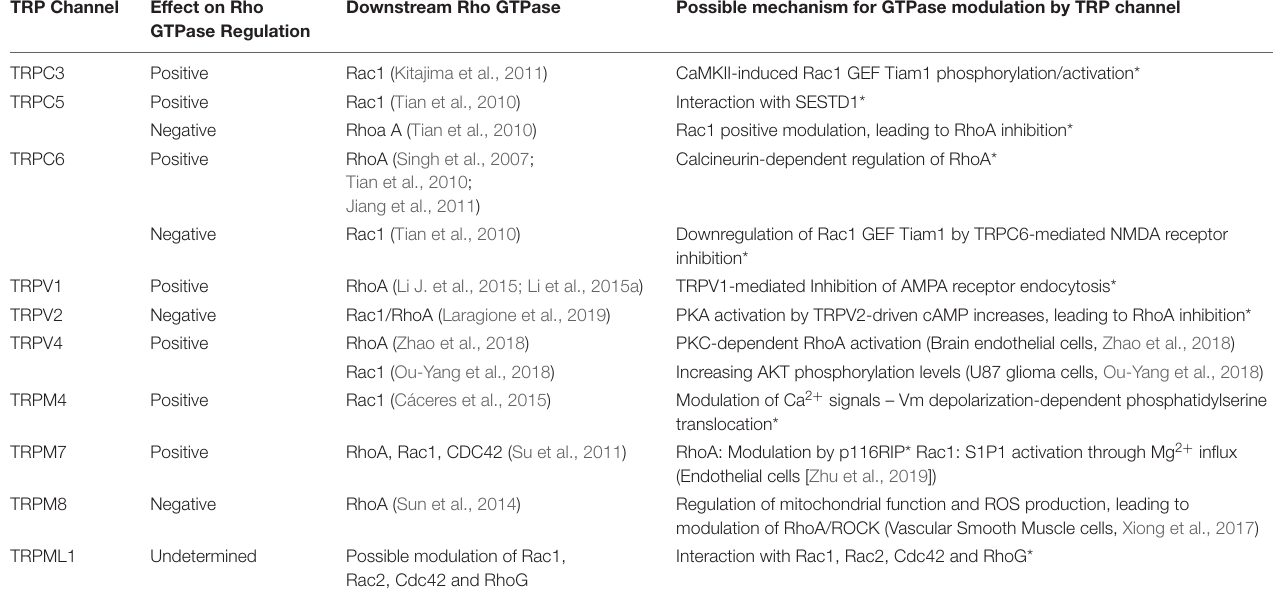
TABLE 3 | Rho GTPases regulated by TRP